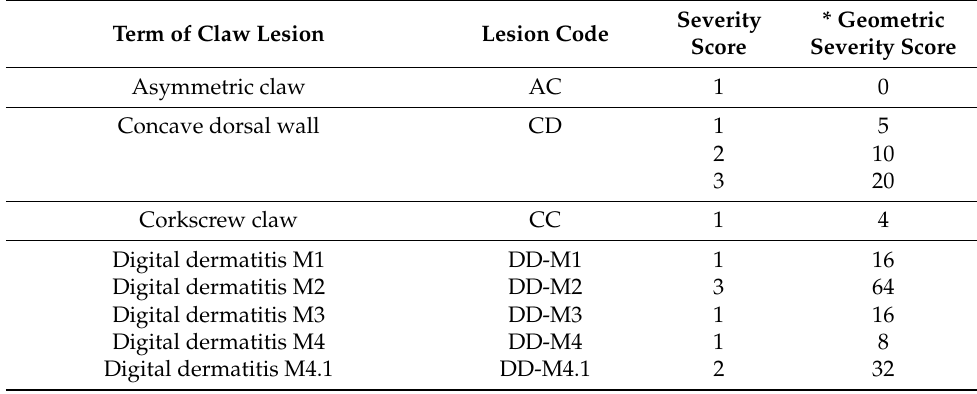
Table 2. Overview of claw lesions, their codes, the three severity scores per lesion as recorded by the electronic documentation system and assigned geometric severity